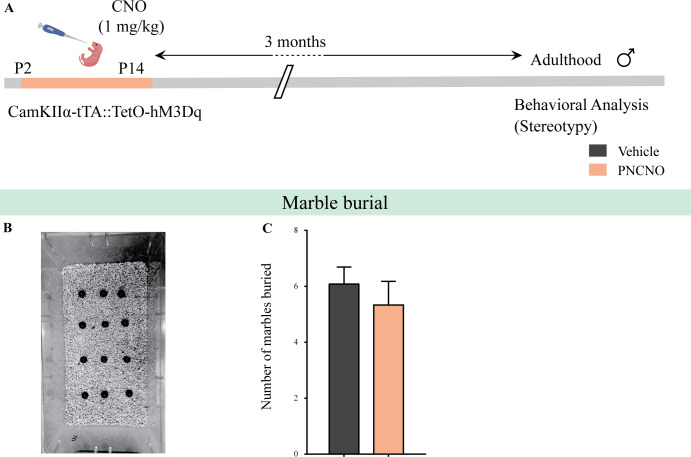
Chronic chemogenetic activation of CamKIIα-positive forebrain excitatory neurons during the early postnatal window does not alter repetitive behavior in adult male mice.(A) Shown is a schematic of the experimental paradigm to induce chronic CNO-mediated hM3Dq DREADD activation in CamKIIα-positive forebrain excitatory neurons using bigenic CamKIIα-tTA::TetO-hM3Dq mouse pups that were fed CNO (PNCNO; 1 mg/kg) or vehicle from P2 to P14 and then left undisturbed for 3 months prior to behavioral analysis to assess repetitive behavior on the marble burial test performed in adult male mice. (B) Shown is a representative image of marble burial test. PNCNO-treated mice did not show any significant difference in the number of marbles buried (C) as compared to vehicle-treated controls (n = 12 per group). Results are expressed as the mean ± S.E.M.